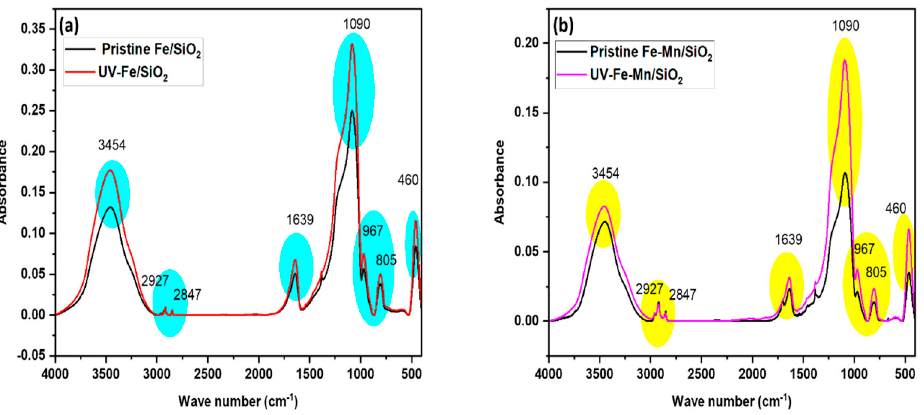
Figure 11. FTIR spectrum ( a ) pristine and UV − irradiated Fe 2 O 3 /SiO 2 (Fe/SiO 2 ) ( b ) Fe 2 O 3 − Mn 2 O 3 /SiO 2 (Fe − Mn/SiO 2 ).